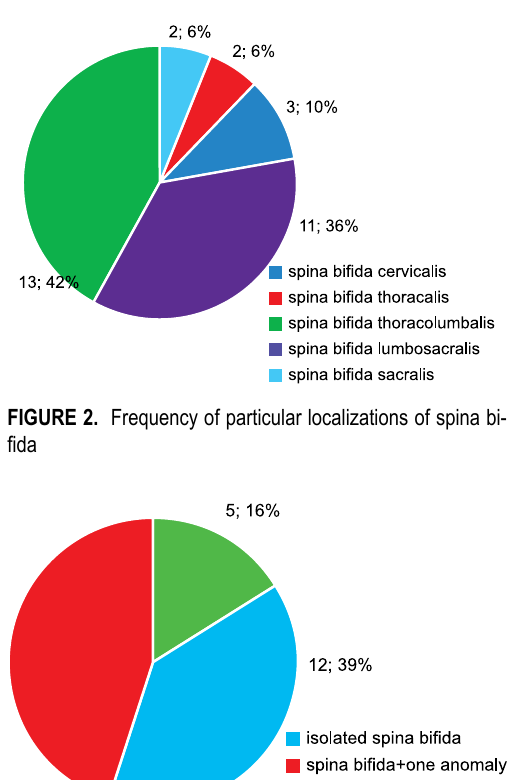
FIGURe 1. Frequency of particular types of spina bifida